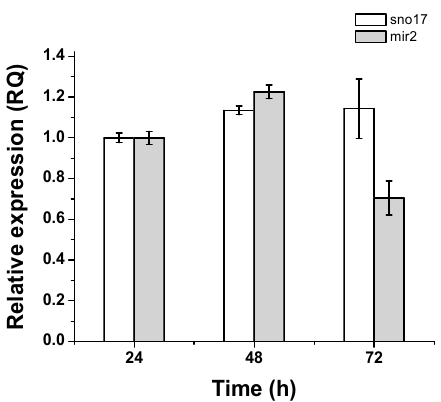
Figure 6. Quantification of the relative abundance of GlsR17 and miR2 from G . lamblia. The trophozoites were grown in TYI ‐ S ‐ 33 medium for 72 h and the samples were taken every 24 h. The error bars indicate standard deviation (SD) from five replicates, see Materials and Methods for details.